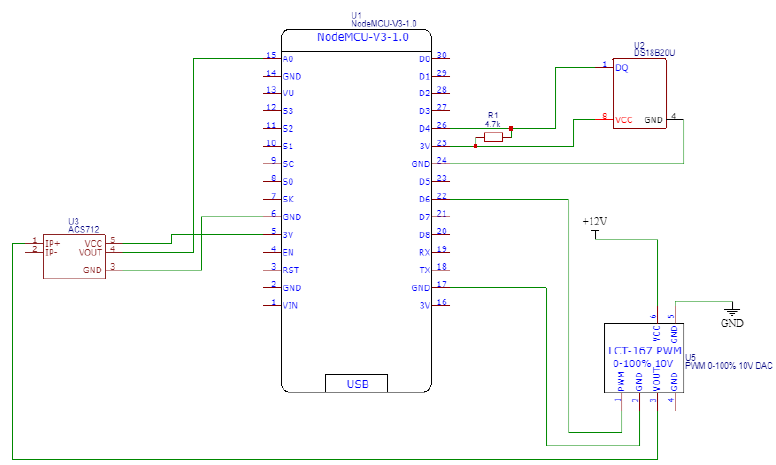
Figure 3. Schematic diagram of the control system using a Wi-Fi transmission module.